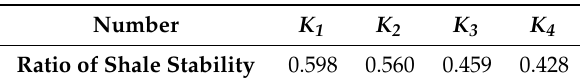
Table 4. Ratio of shale